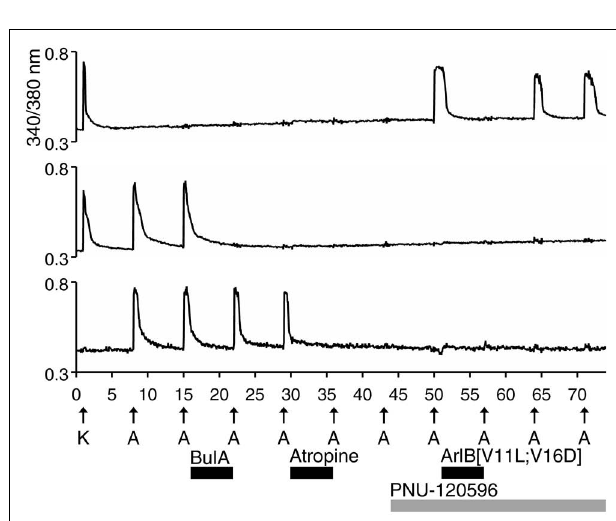
FIGURE 5 |Variable combinations of α 6 β 4 and α 3 β 4 nAChRs are expressed together.The two traces shown are from mouse DRG neurons. Similar results were obtained with rat DRG neurons. In all of the β 4-expressing neurons, responses to ACh were partially blocked by 500 nM BuIA[T5A;P6O], which selectively blocks α 6 β 4 over α 3 β 4 nAChRs (see Table 1 ).The bottom trace illustrates greater block by BuIA[T5A;P6O] than the top trace.